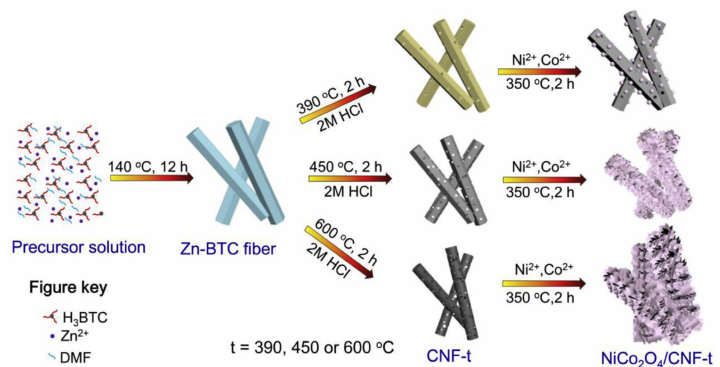
Figure 16. Illustration of synthesizing porous carbon fibers from self-assembled zinc trimesic acid templates. Reprinted with permission from [110]. Copyright © 2018 Elsevier